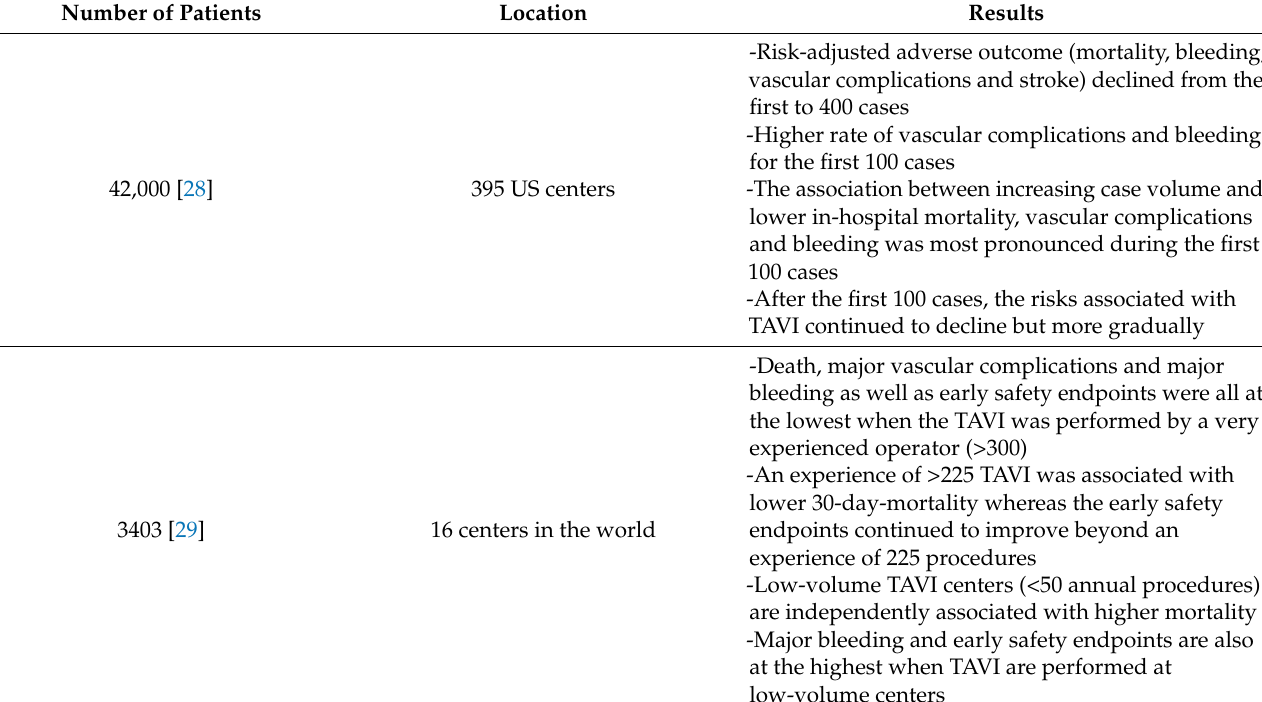
Table 3. Studies assessing the learning curve for